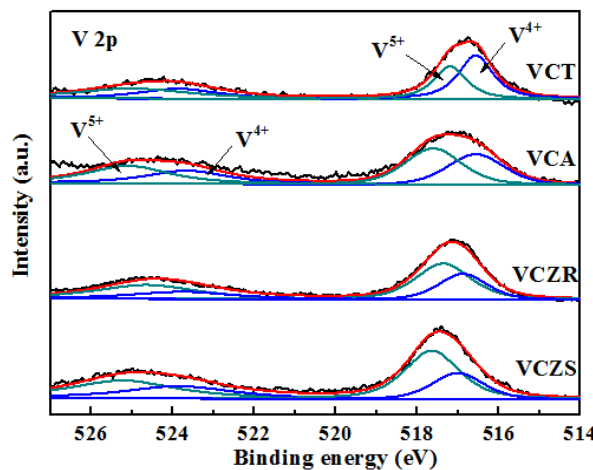
Figure 5. V 2p XPS high-resolution scans spectra of different samples.